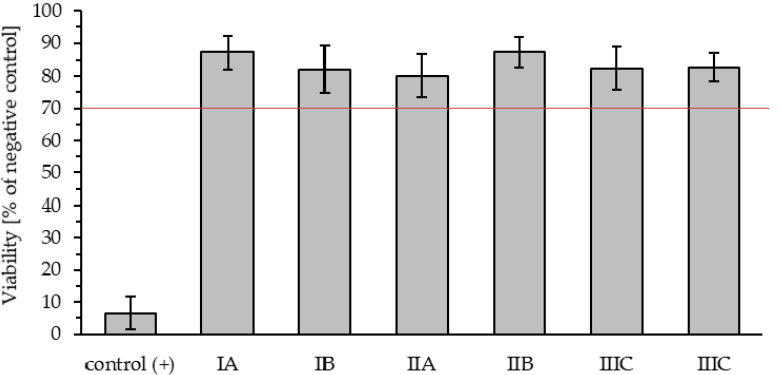
Figure 11. The viability of the L929 cells cultured with extracts of the dECM–1 mg/mL (MTT assay, MV ± SD, n = 4). MV ± SD, n =